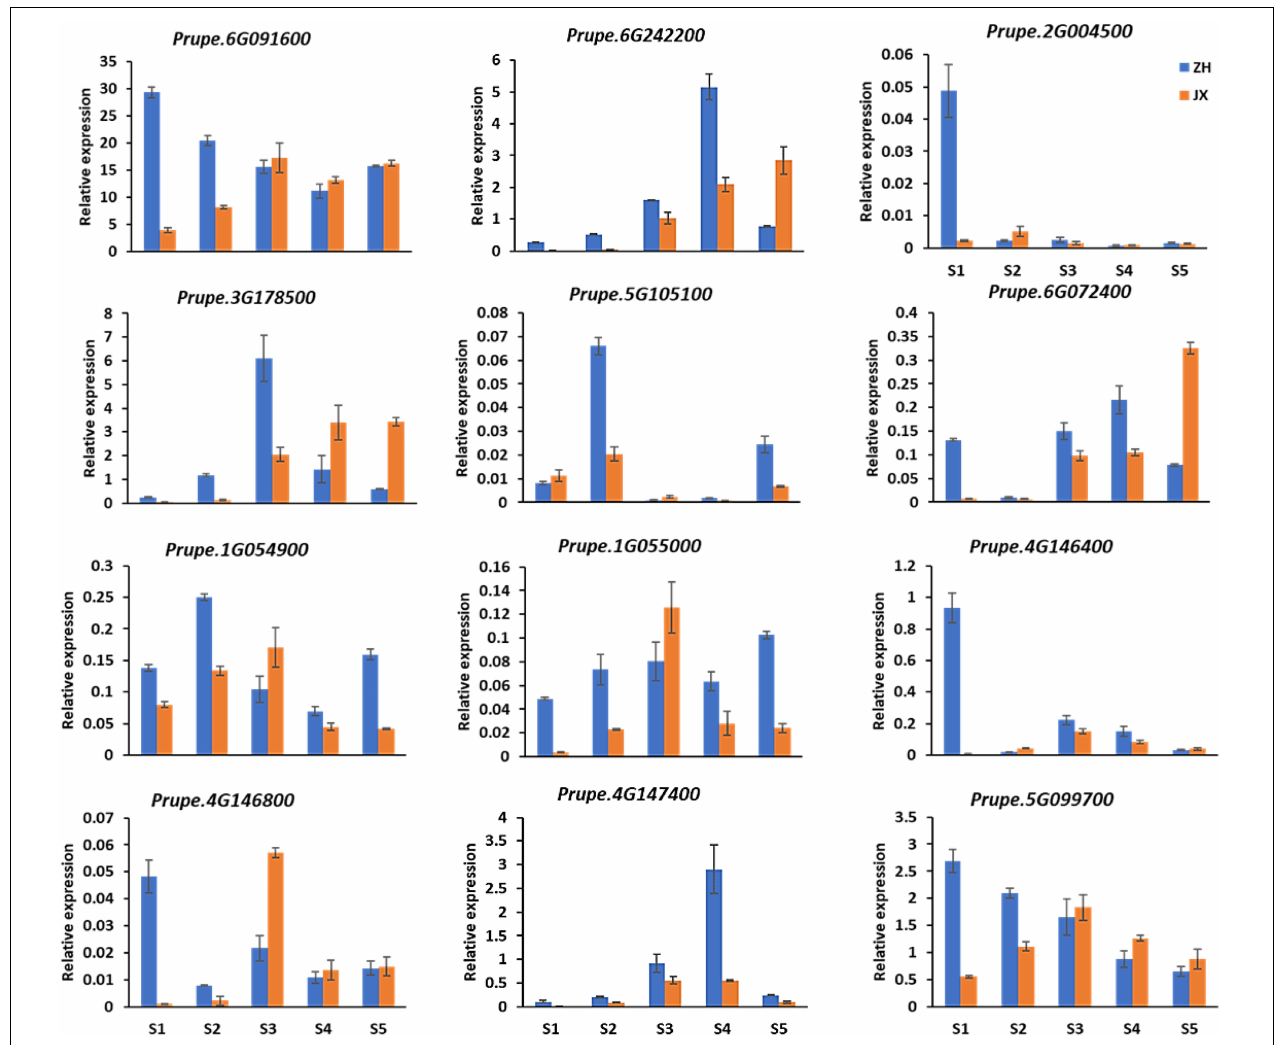
FIGURE 9 | Expression analysis of DEGs by qRT-PCR at S1–S5. Error bars indicate standard deviation from three biological and technical replicates of